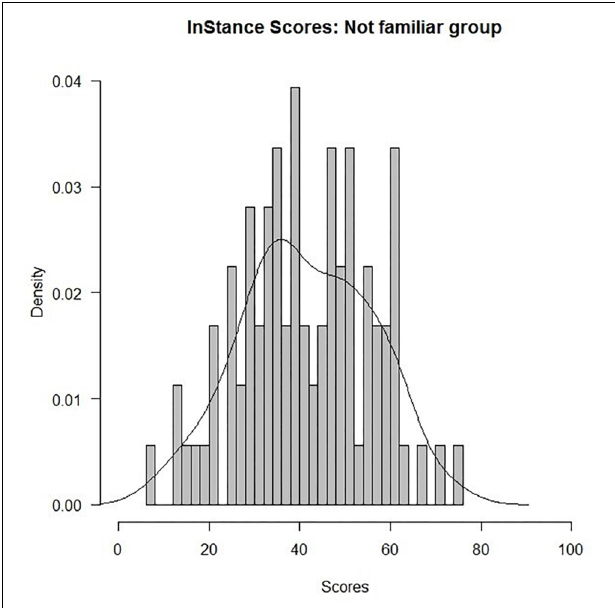
FIGURE 5 | ISS (individual averages) distribution for the not familiar group ( N = 89).